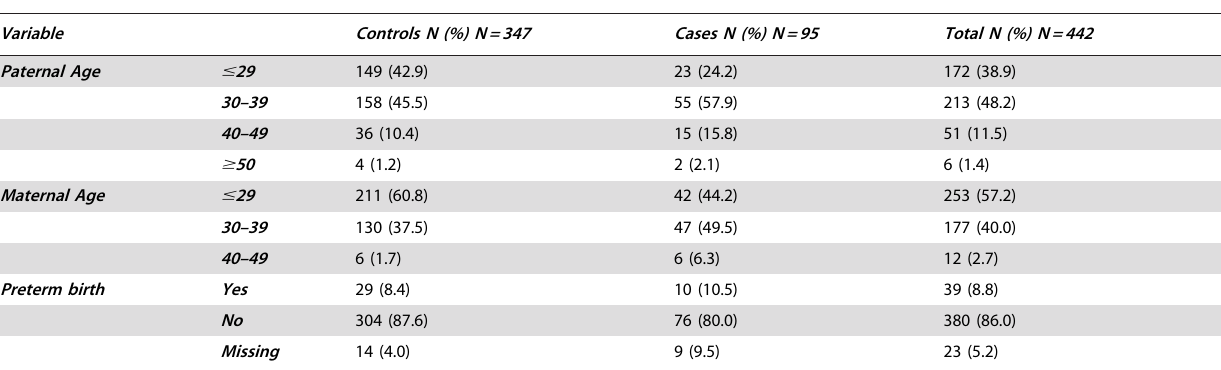
Table 1. Characteristics of the study sample.